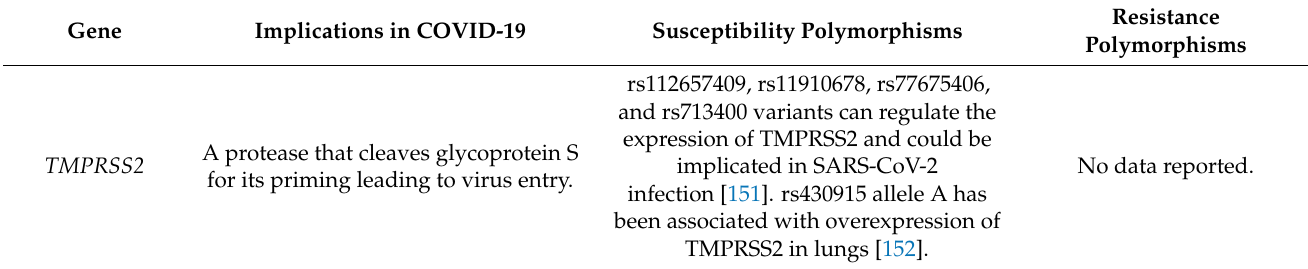
Table 2. Polymorphisms implicated in the development or resistance to COVID-19 and their relation- ship with the immune